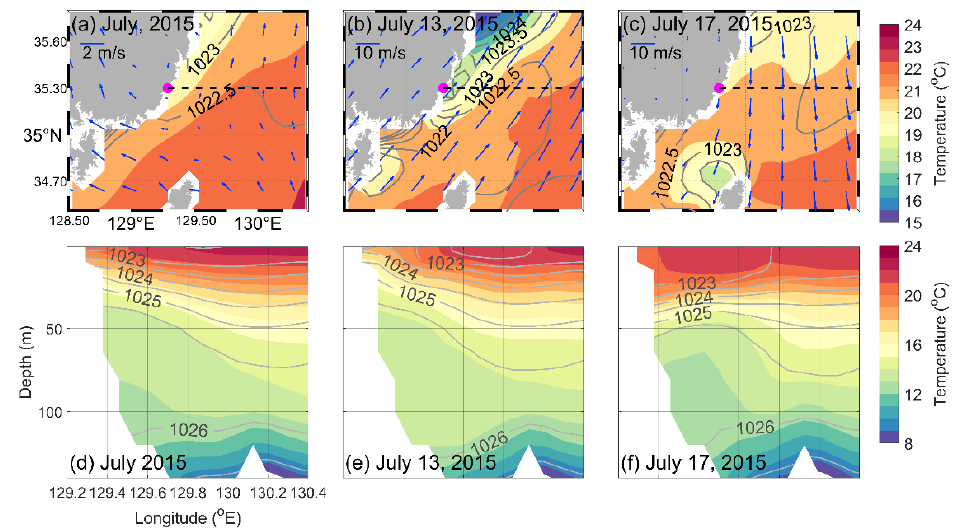
Table 3. Tidal ellipse parameters of dominant semidiurnal tidal components for the ADCP obser- vation and DR_M output. Figure 4. Average sea surface temperature, 10 m winds (arrows), and potential density (grey contours) from the DR_M, ( a ) in July, ( b ) on 13 July, and ( c ) on 17 July 2015; zonal sections for average water temperature and potential density (grey contours) ( d ) in July, ( e ) on 13 July, and ( f ) on 17 July 2015, along the black dotted line in ( a – c ). The contour interval of the potential density is 0.5 kg/m 3 .